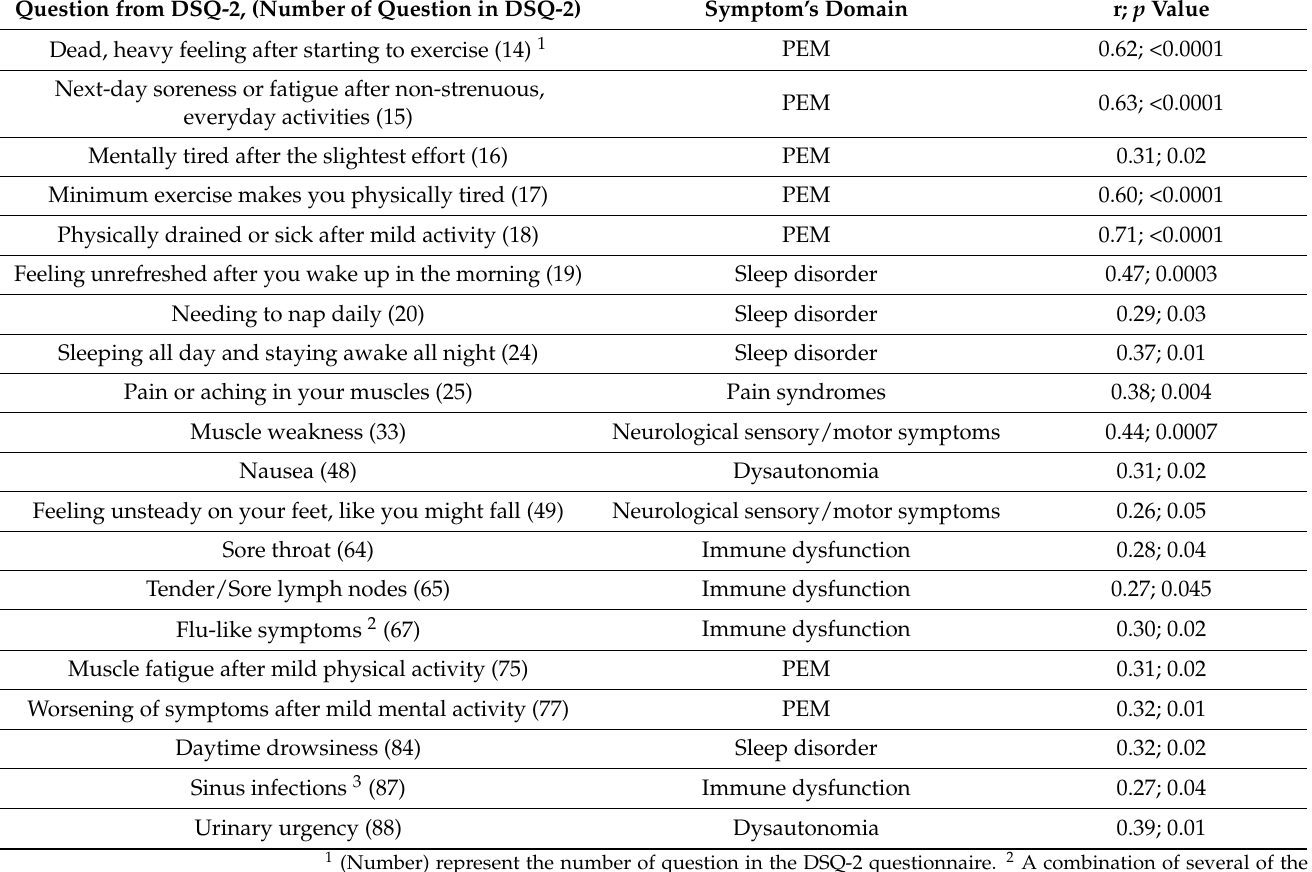
Table 3. Symptoms that correlate with the severity of fatigue according to the composite symptoms scores from the DSQ-2